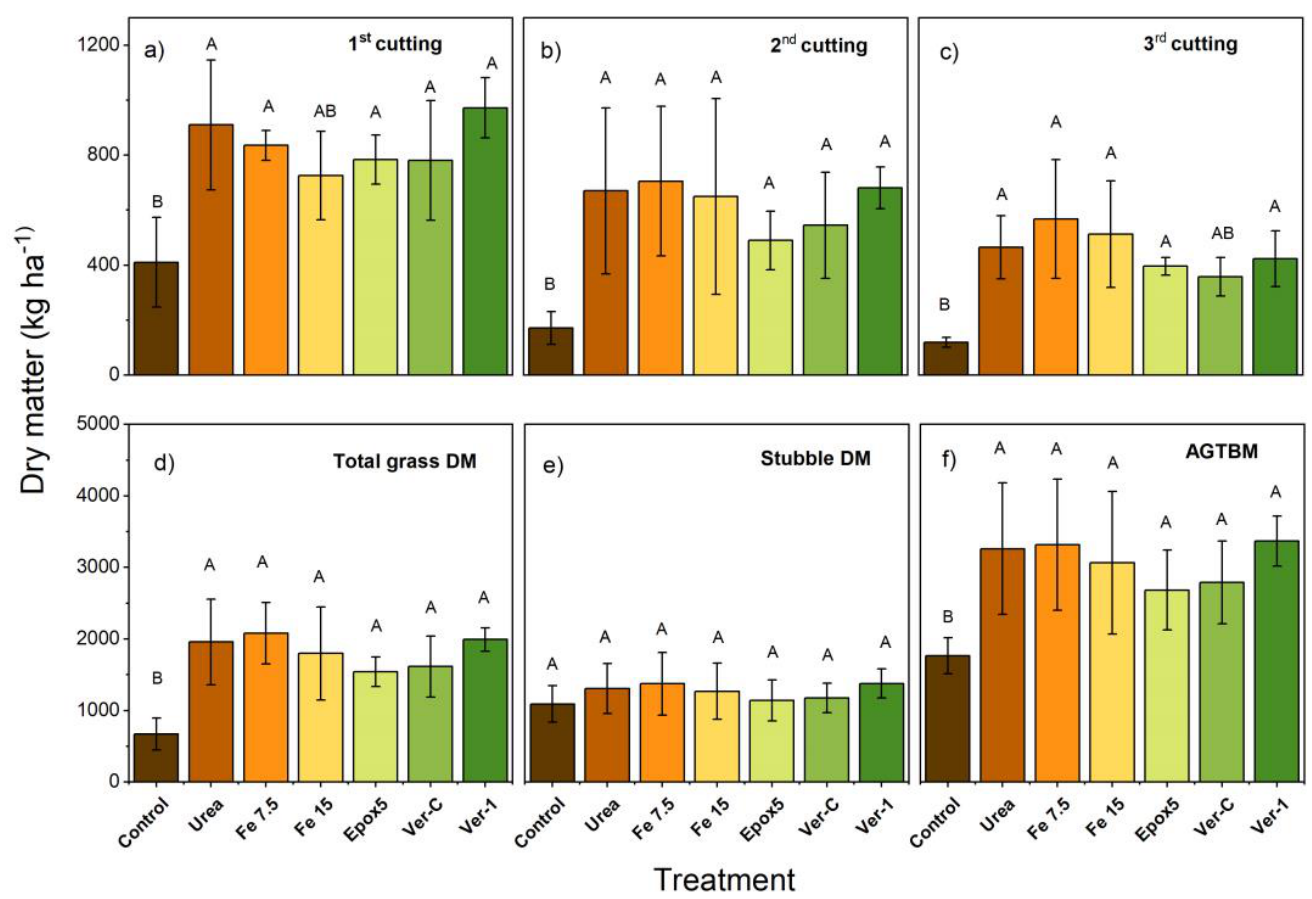
Figure 5. ( a – c ) Monthly and ( d ) total grass DM, ( e ) stubble DM and ( f ) above-ground total biomass (AGTBM) DM. The upper-case letters show the significant difference between treatments at p < 0.05 ( n = 5). The error bar indicates the standard deviation ( n = 5).